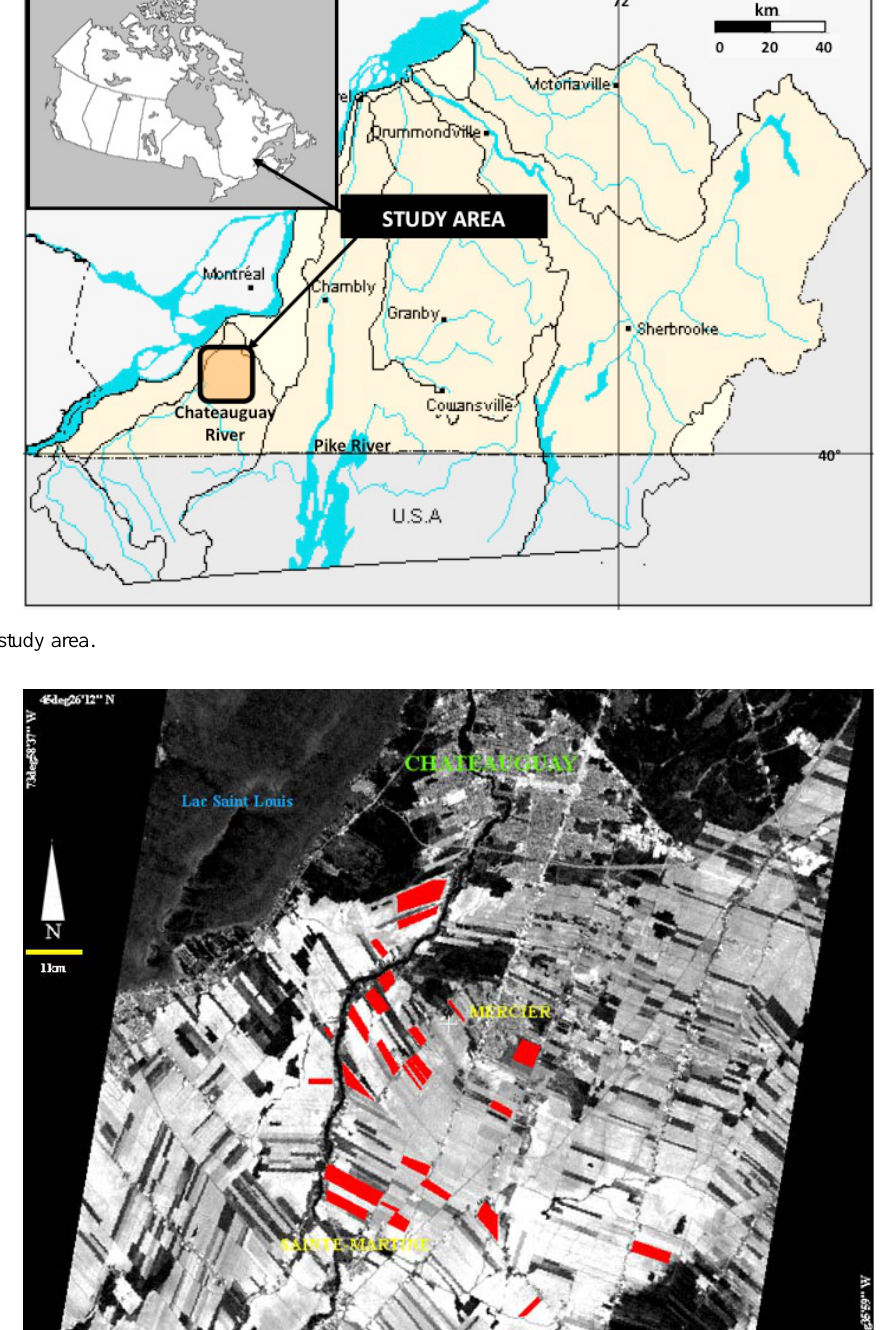
difference of 1.8% was observed between the two Fig. 2. Location of the parcels (Airborne photography over Chateauguay watershed).